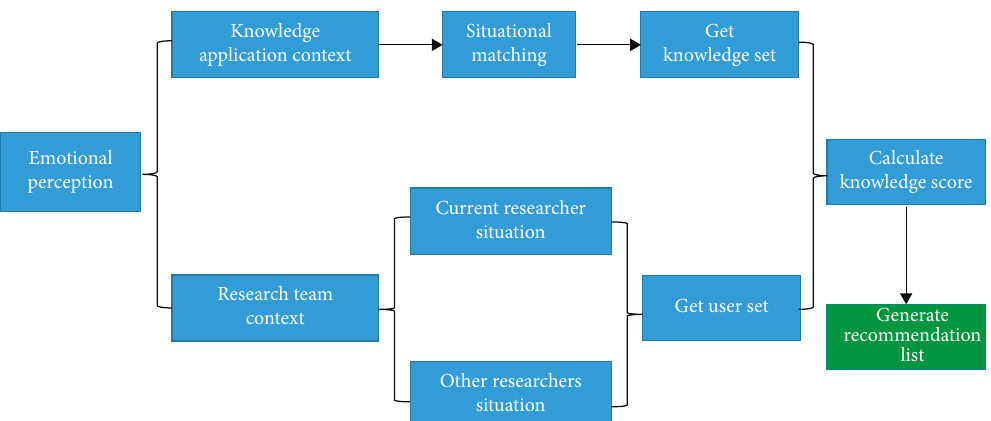
Figure 1: An overview of the proposed TKCM